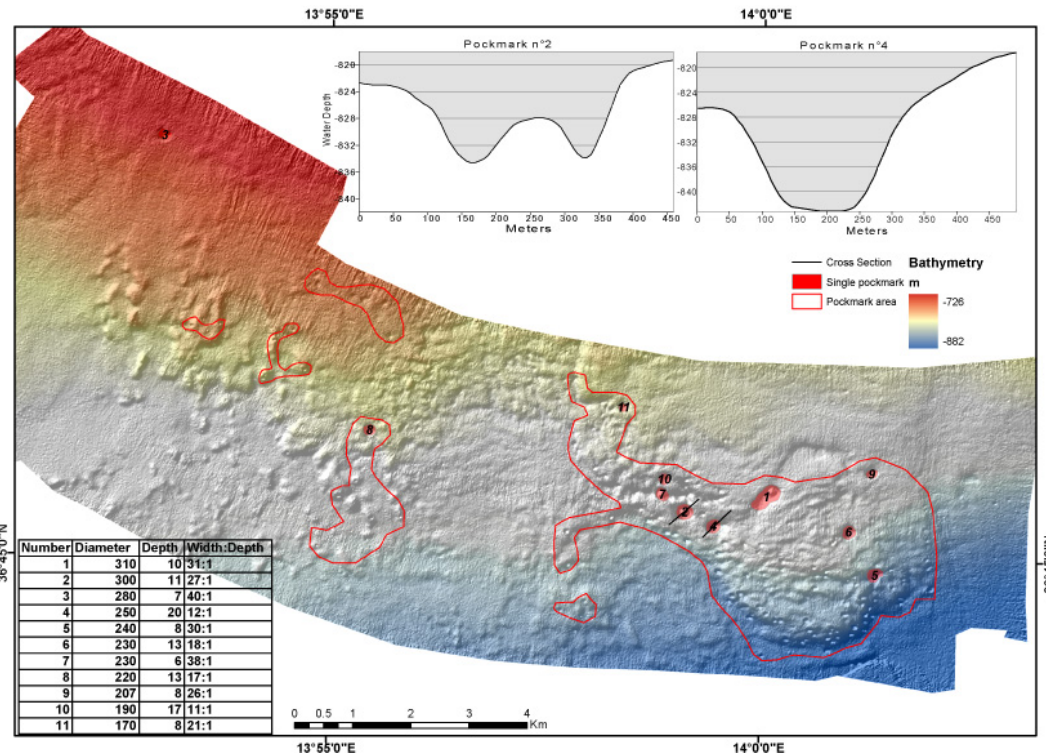
Fig. 2. Shaded relief DTM of the study area (5m resolution and 10 × vertical exaggeration) showing the complex, rough topography punctu- ated by many sub-circular depressions interpreted as pockmarks. The 11 major pockmarks, with diameters greater than 200m, are numbered from maximum to minimum dimension. Their geo-morphometric characteristics are listed in the table; the bathymetric profiles show the cross section of two main pockmarks showing the different internal geometry, respectively U-shaped and V-shaped with internal positive relief. Furthermore, the image reveals that the major pockmark (Number 1) is formed by two partly coalescent depressions. Table 4. List of major established (chemosymbiotic bivalves, and tubeworm) and putative (gastropods, callianassid) metazoans associated with pockmark cold seepage at the GBPF. MEDCOR MEDCOR MEDCOR MEDCOR MEDCOR MEDCOR DECORS DECORS 69